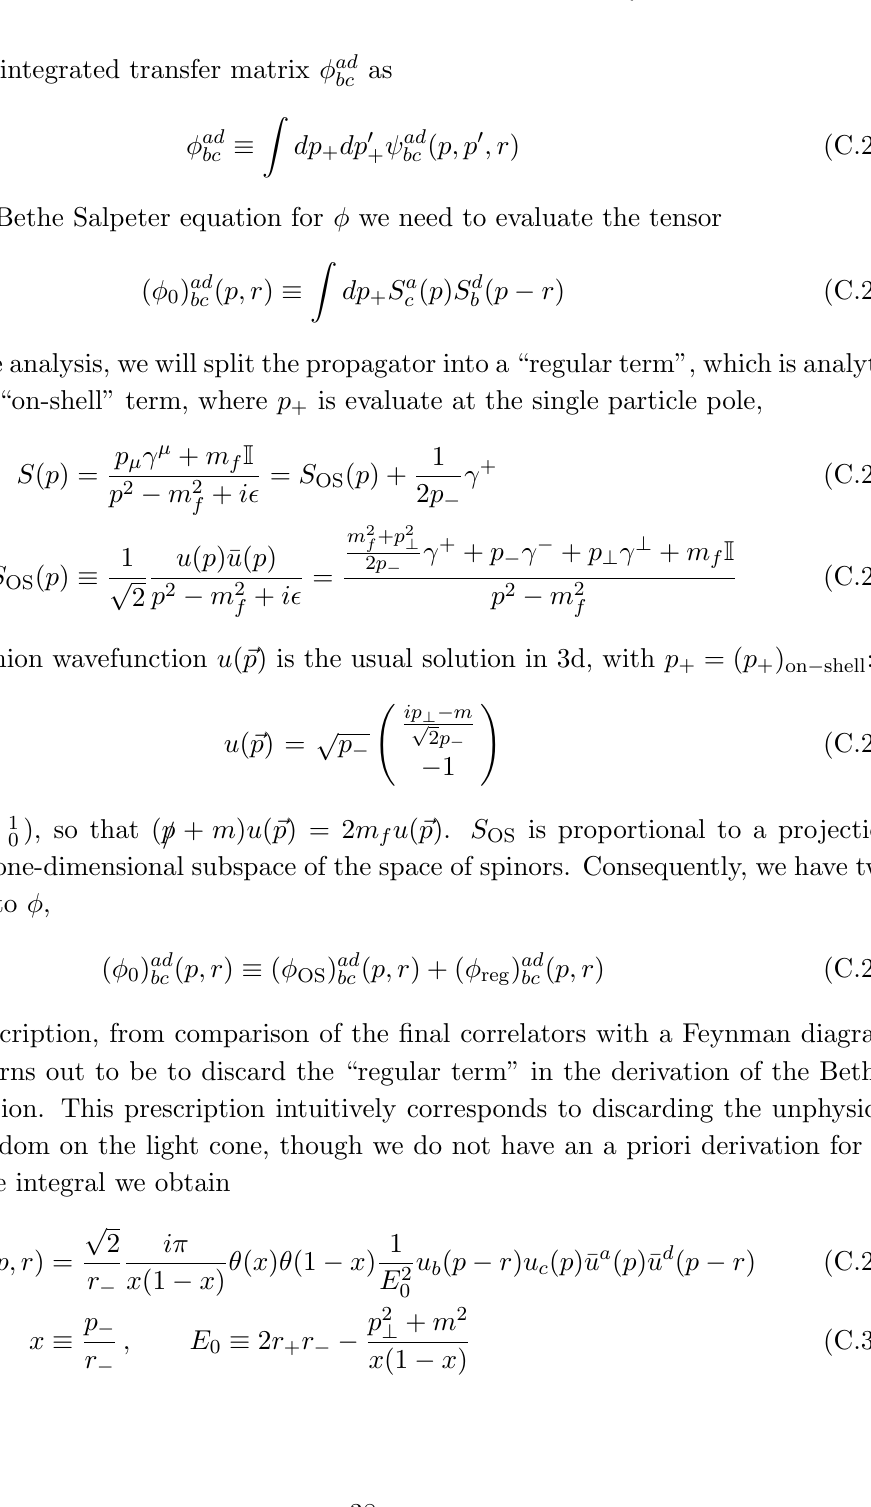
Figure 4 . Symbolic Bethe-Salpeter equation for the large N f CS